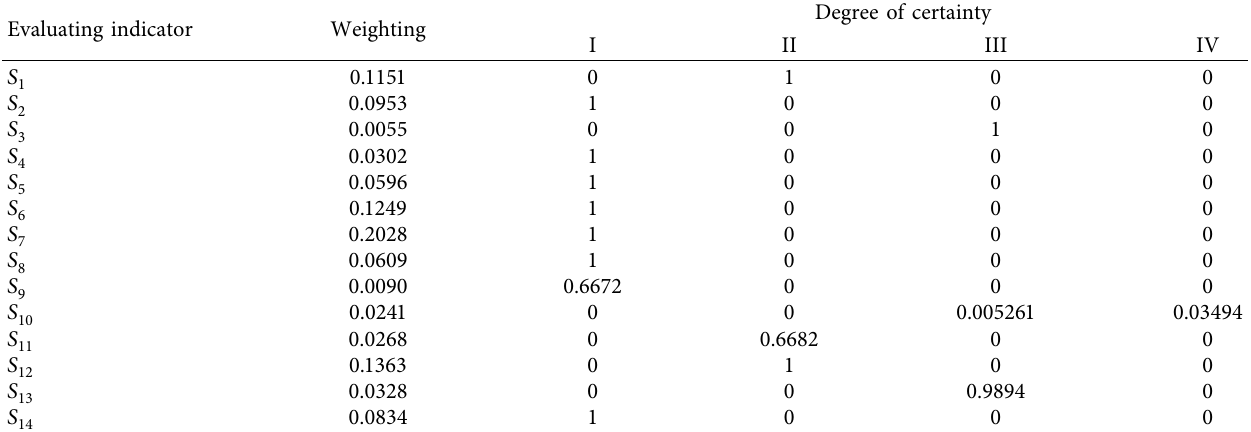
Table 5: Calculation data of stability evaluation of sample 19 goaf.